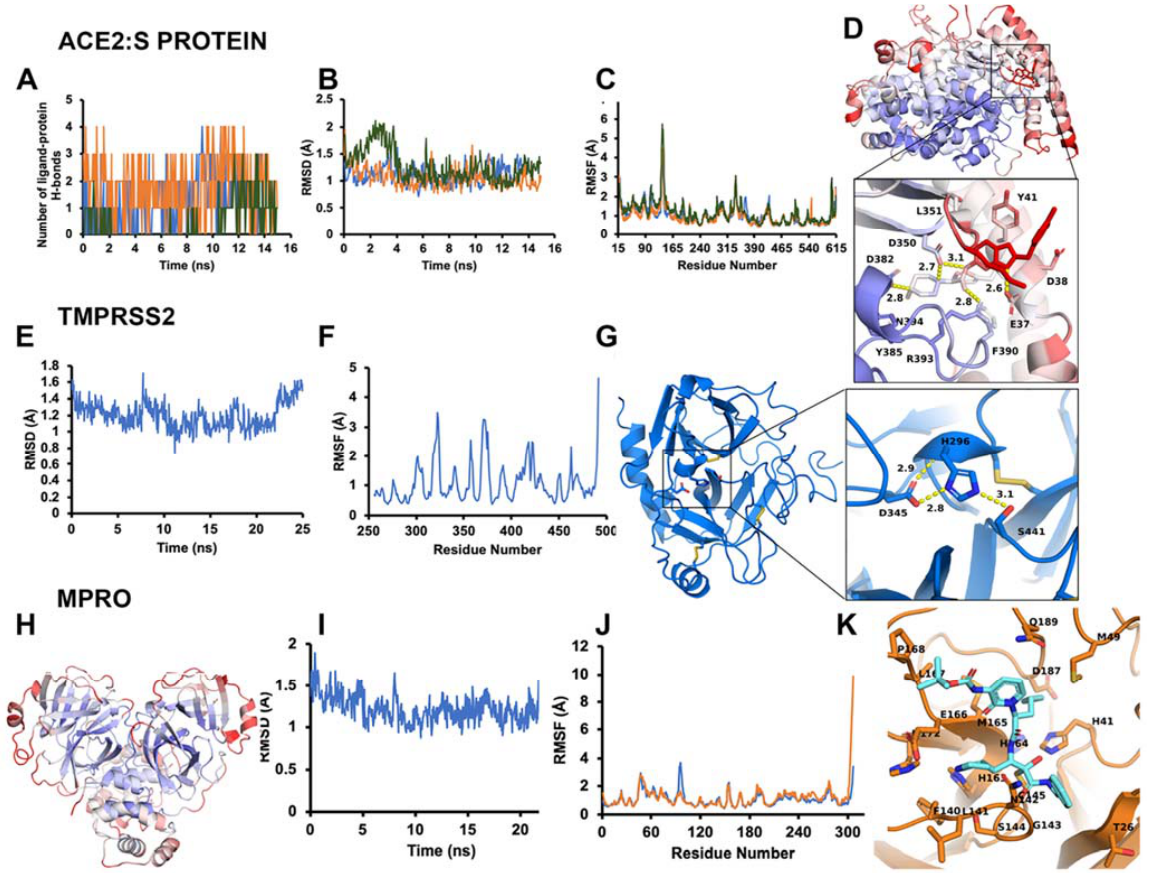
Figure 4. Modeling requires molecular dynamics to reflect optimal inhibitor-binding sites. ( A – D ) ACE2–S protein stabi- lization and effect of ligand binding at allosteric site. ( A ) Number of hydrogen bonds for each ligand with ACE2 against each frame of the simulation. Blue is ligand 300, orange is ligand 392, green is ligand 488. ( B ) RMSD of ACE2 across every frame in the simulation, bound to different ligands. ( C ) RMSF per residue of ACE2 in each MDS bound to different ligands. ( D ) RMSF heat-mapped onto ACE2 and ligand 300. A call-out box shows a close-up of ligand and binding site. Ligand and binding site residues represented as sticks with labels and interaction distances. The scale is a BWR gradient from 0 to 2.0 Å RMSF. ( E – G ) TMPRSS2 dynamics reveal the catalytically active form suitable for inhibition. ( E ) RMSD in Å across the 25 ns MDS trajectory mapped as a 2D plot. ( F ) Per residue average RMSF in Å across the trajectory mapped as a 2D plot. Disulfide bonds and catalytic triad are represented as sticks. The scale is a BWR gradient from 0 to 2.0 Å RMSF. ( G ) Post-cleavage (mature protease) extracellular domain of TMPRSS2. Call-out box shows close-up of canonical serine protease catalytic triad of mature TMPRSS2, with distances of polar contacts. (H-K) Model refinement for M pro reveals ligand-binding sites suitable for docking. ( H ) Average RMSF per residue heat-mapped onto the M pro structure. The scale is a BWR gradient from 0 to 2.0 Å RMSF. ( I ) RMSD of M pro for each frame of the simulation. ( J ) Average RMSF per residue of M pro (each chain measured separately). ( K ) M pro (orange) with small ‐ molecule inhibitor (cyan).